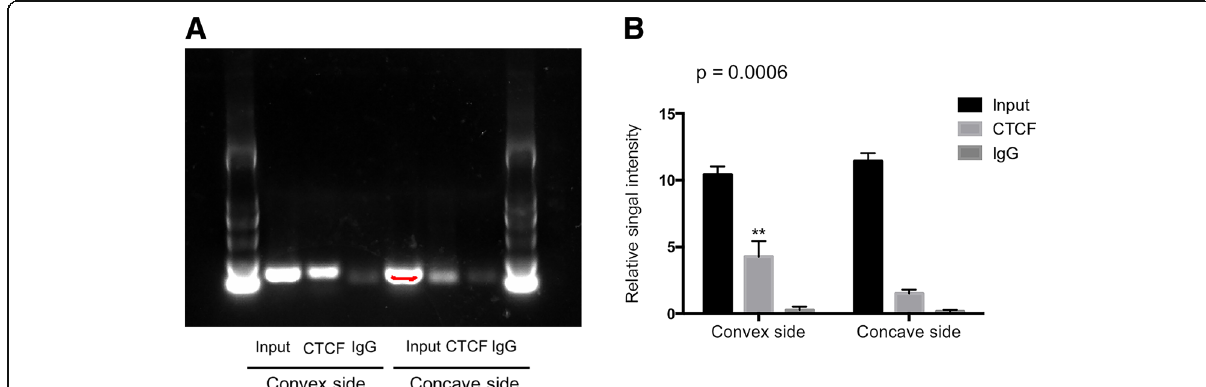
Fig. 6 H19 expression was regulated by CTCF occupancy in the H19 imprinting control region. a , b Paravertebral muscles were harvested from AIS patients during the fusion surgery. The tissues were subjected to Nuclei preparation and chromatin digestion, and the CTCF-binding status at the H19 ICR were assessed with CHIP assay, as described in Materials and Methods. a represent electrophoretogram of PCR product by 10% polyacrylamide gel electrophoresis. b CTCF occupancy in the H19 ICR showed significantly reduced occupancy in the concave-sided muscle tissue samples. The experiments were performed three times. Results are expressed as mean±SEM. n =4 in each group. **, P <0.01 versus concave